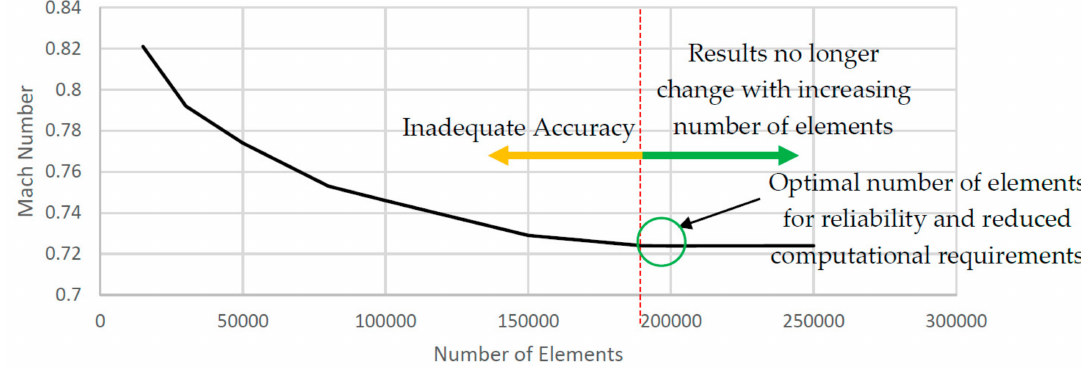
Figure A1. Mach number comparison aft of normal shock.